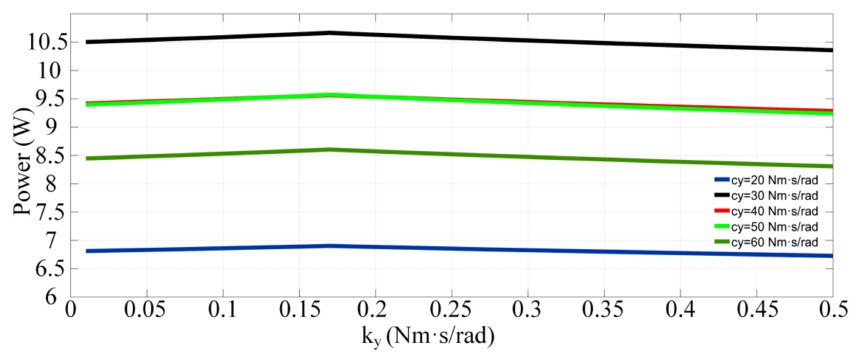
Figure 7. The effect of stiffness coefficient on power under different damping coefficients.